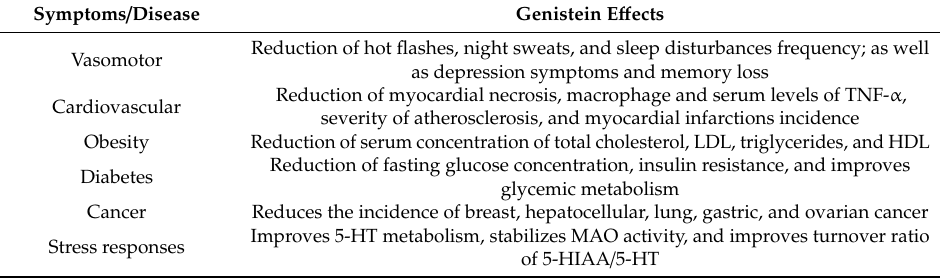
Table 1. E ff ects of genistein on menopause symptoms and some related Table 1. Effects of genistein on menopause symptoms and some related diseases.